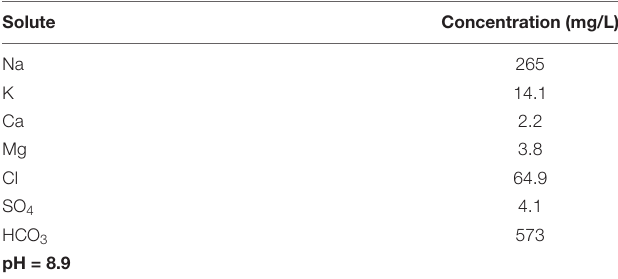
TABLE 2 | Chemical composition of Lake Chamo water used for geochemical modeling. Solute